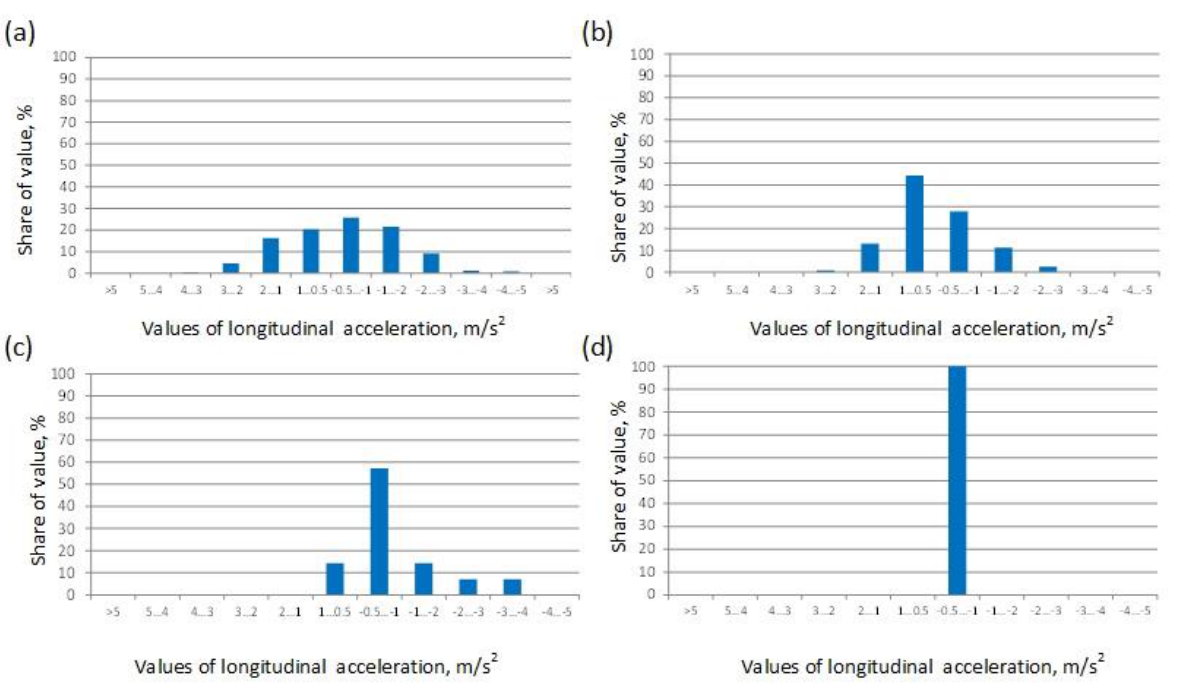
Figure 8. Distribution of the extreme values of longitudinal acceleration and deceleration maneuvers for various route sections: ( a ) city road; ( b ) suburban road; ( c ) expressway (dual carriageway); ( d ) highway. Table 1. Distribution of the extreme values of acceleration and deceleration maneuvers for various route sections: (a) city road; (b) suburban road; (c) expressway (dual carriageway); (d) highway. Acceleration Distribution, %